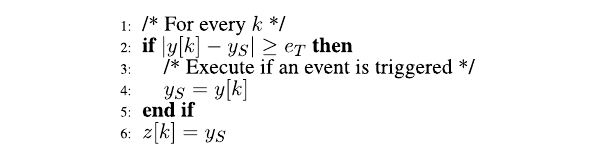
FIGURE 3 | Pseudocode for a MBET encoder